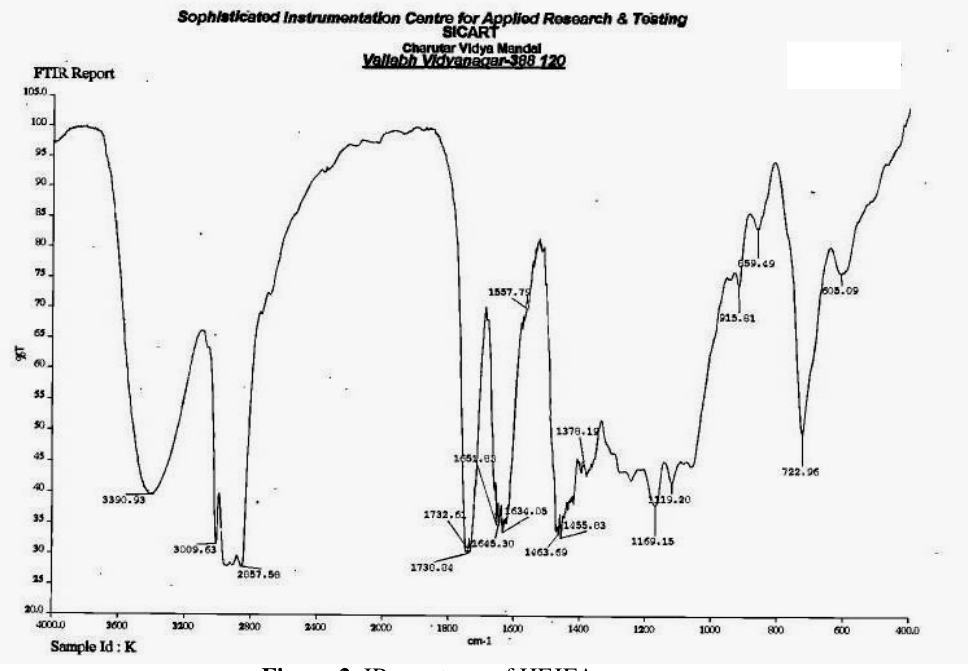
Figure 2. IR spectrum of